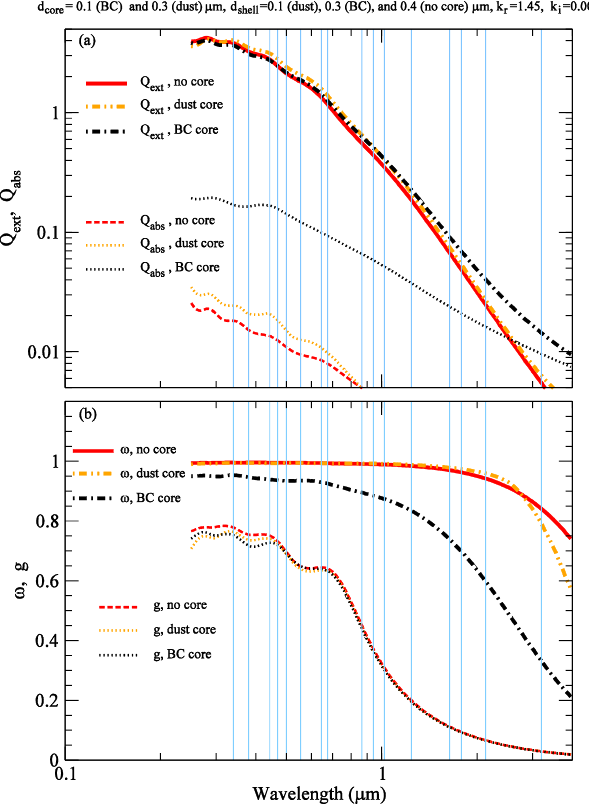
Figure 1 . Fig. 1. Dependence of Q ext , Q abs , ω , and g on wavelength ( λ) for three types of 0.4µm particles under selected conditions, with the 16 wavelength values in the lookup tables marked as vertical